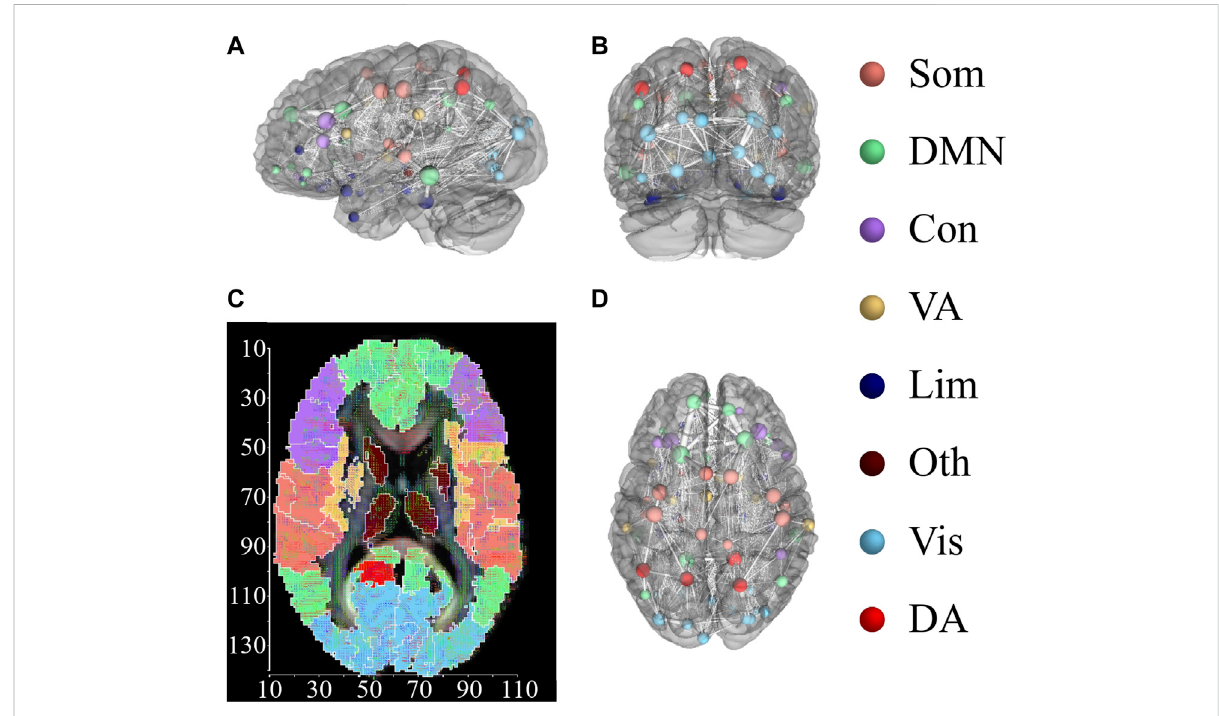
Distribution of94 AAL2 brainregions within 8cognitivesystems. (A,B) and (D) show 3-dimensional spatial distributionofthe 94brain regions in 3 directional views, with left view (A) , back view (B) , and top view (D) . Brain regions with the same color belong to the same cognitive systems. The connections between brain regions are displayed, with the thickness representing the connection strength. (C) Spatial mappings show the distribution of 8 cognitive systems. The color of map is connected to the cognitive system shown in the right column. This fi gure is drawn by using DSI